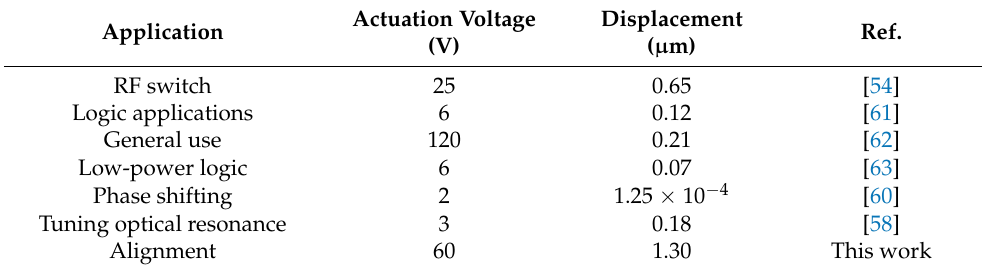
Table 3. Performance of published MEMS actuators for waveguide